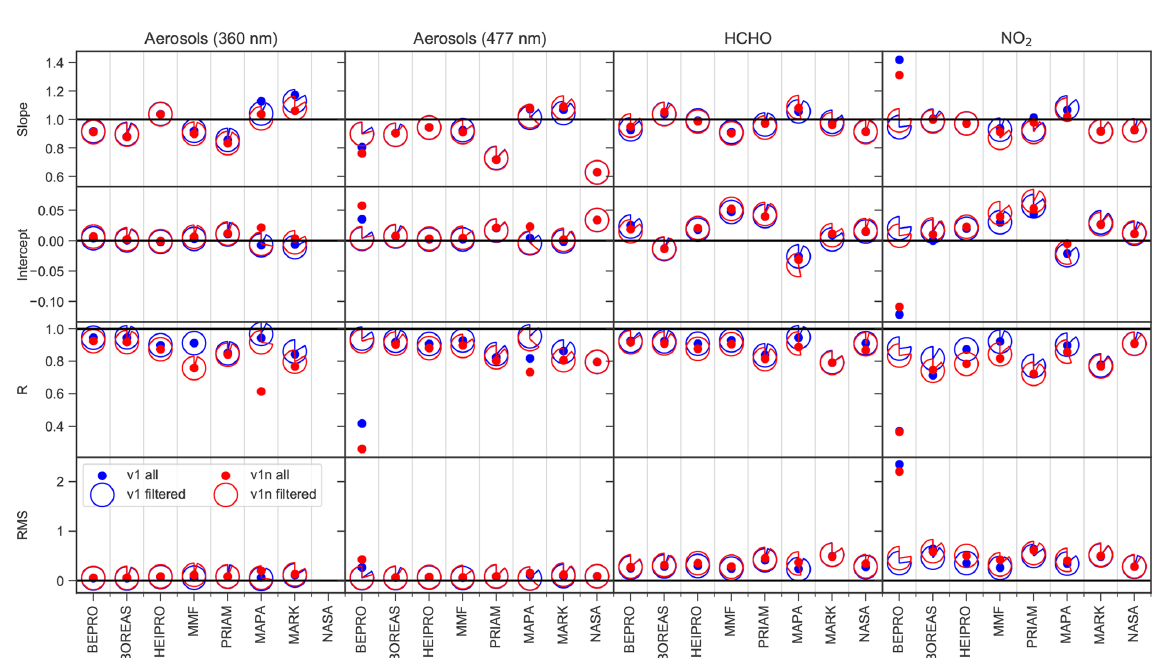
Figure 15. Slope, intercept, regression coefficient, and RMS for the correlation between true and retrieved aerosol extinction as well as HCHO and NO 2 number concentrations at all altitudes. Intercept and RMS values are per kilometre for aerosols and 10 11 moleccm − 3 for HCHO and NO 2 . Cloud and fog scenarios (AER8, AER9, AER10) are excluded from the regression